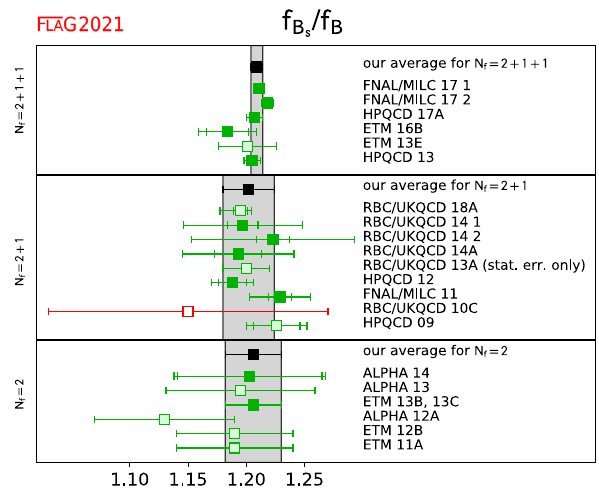
Fig. 28 Ratio of the decay constants of the B and B s mesons. The values are taken from Table 42. Results labelled as FNAL/MILC 17 1 and / f / f FNAL/MILC 17 2 correspond to those for f B B + reported in FNAL/MILC 17. The significance of the colours is explained in Sect. 2. B 0 and f B s s The black squares and grey bands indicate our averages in Eqs. (209), (212), and